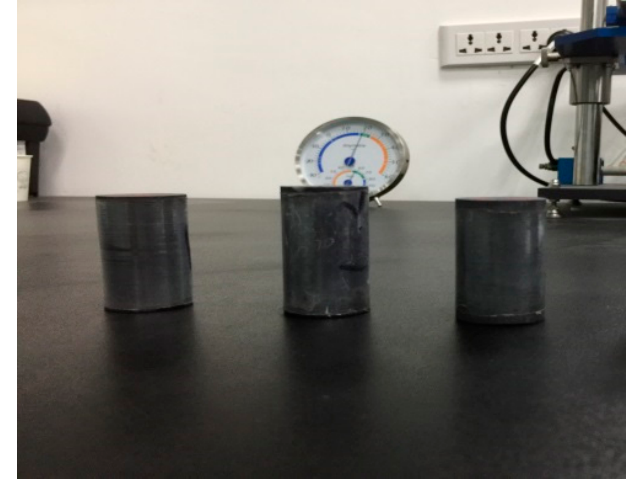
Figure 1. The three shale rock specimens (units: cm) . Table 1. The main physical characteristics of rock specimens .